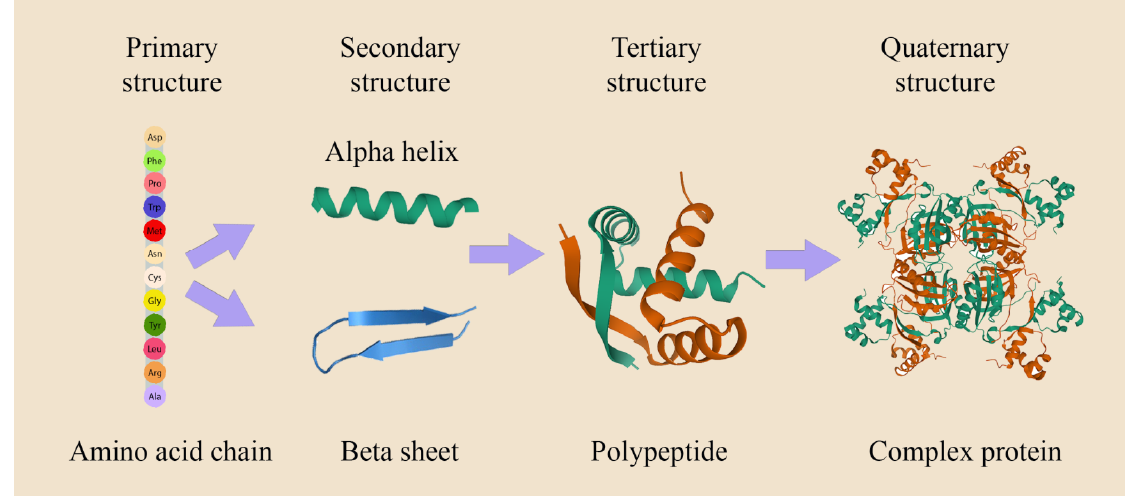
Figure 2. Hierarchy of protein structures.